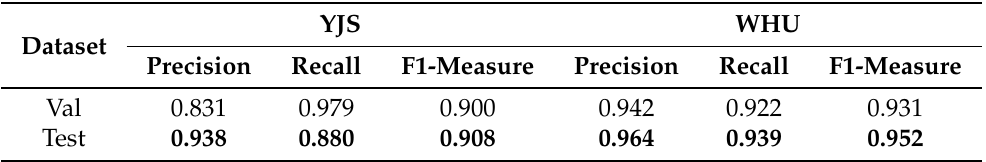
Table 8. Demographic prediction performance comparison by three evaluation metrics.The results of the test areas in the two data sets are shown in